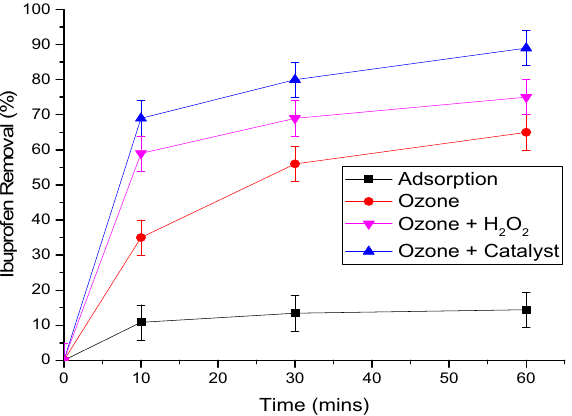
Figure 7. Ibuprofen removal using different treatment methods. Experimental conditions: pH—6.5, temperature 20 ± 1 °C, initial Ibuprofen concentration—5 mg/L, catalyst—1.00% (w/v), ozone dose—2 mg/L, H 2 O 2 dose—0.5